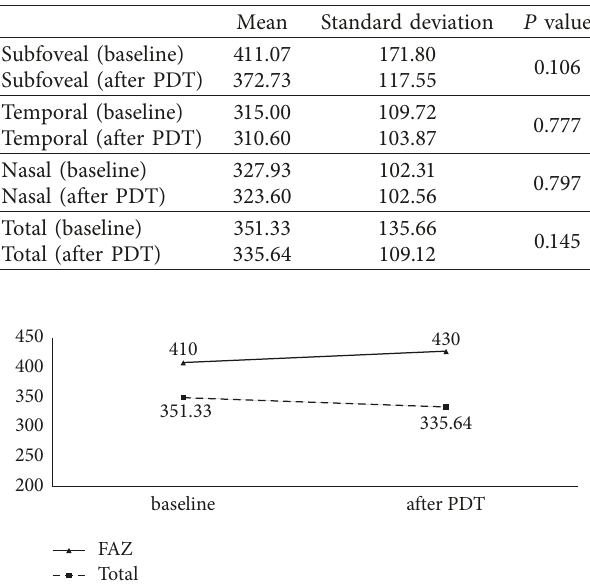
Figure 4: Comparison of FAZ and total choroidal thickness before and three months after treatment.